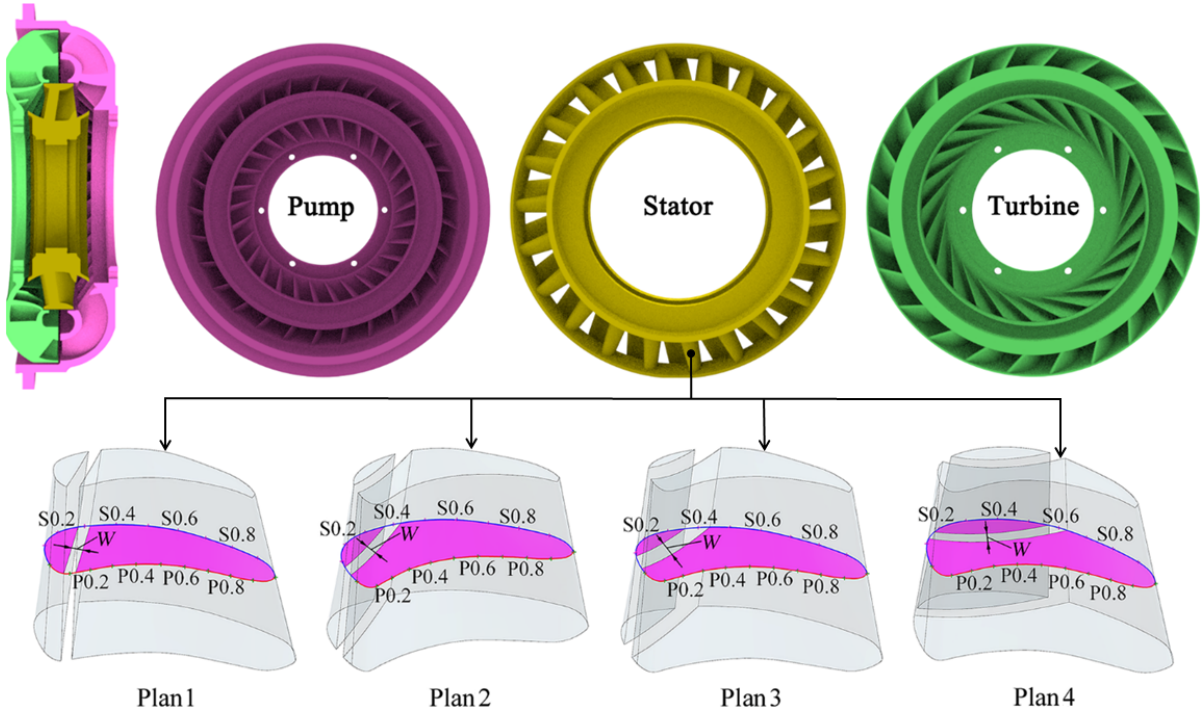
Figure 7. HTC and slot geometric model. Table 3. Design parameters of suppression slots.